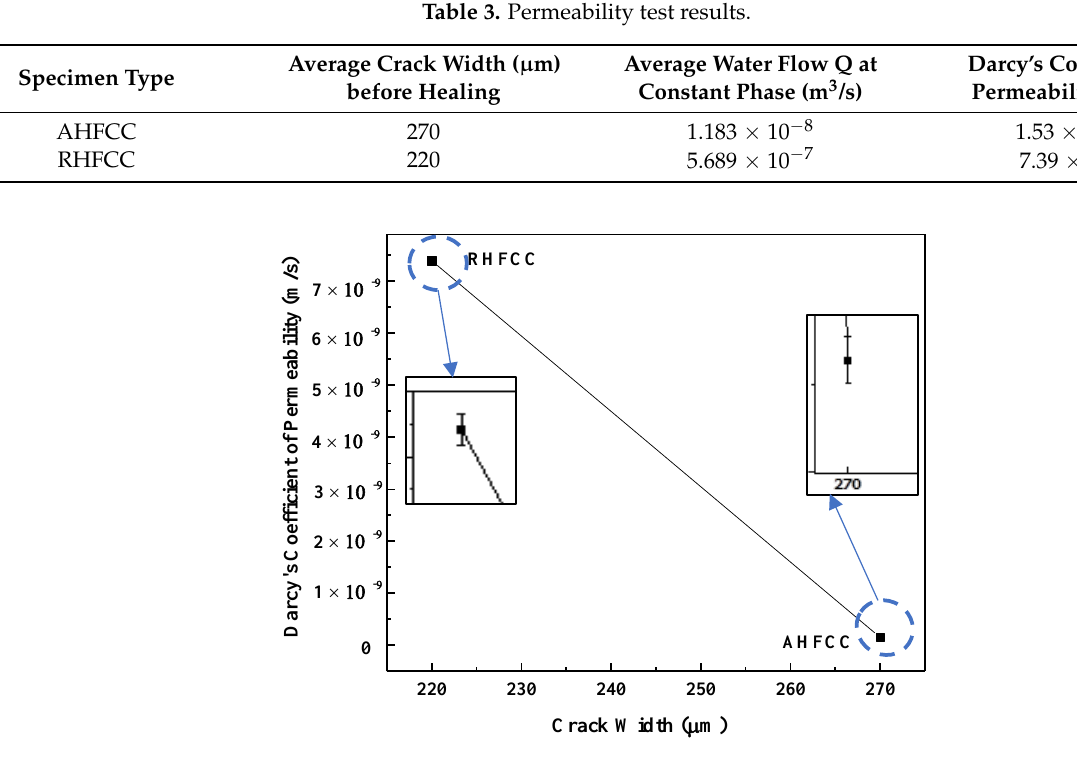
Figure 11. Darcy’s coefficient of permeability K according to specimen type.